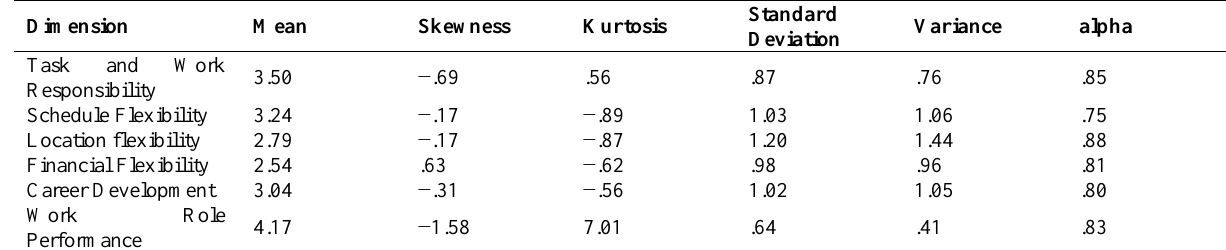
Table 1: Descriptive statistics of i-deals and work role performance